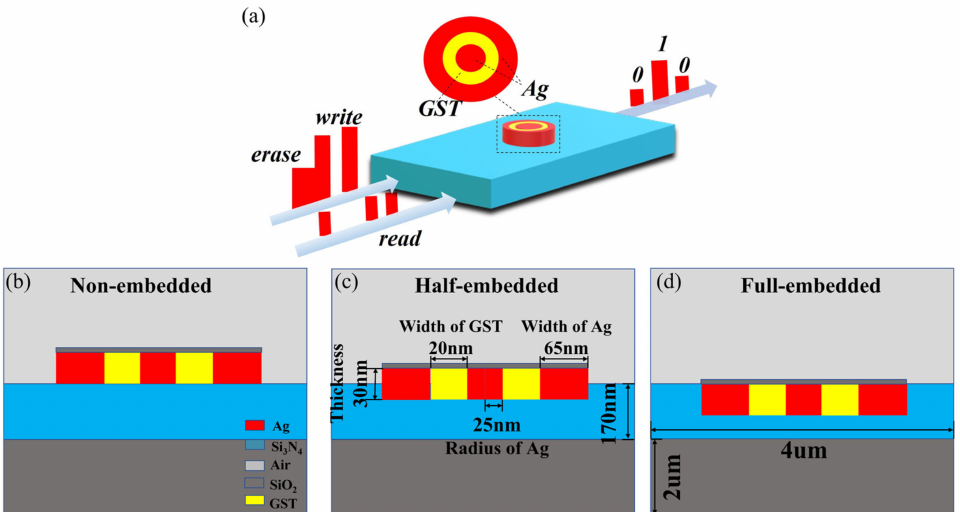
Figure 1. Schematic diagram of the devices. ( a ) Plasmonically-enhanced all-optical integrated phase- change device. PCM is surrounded by a plasmonic nanostructure consisting of two silver rings and is placed on a Si 3 N 4 waveguide. The plasmonic enhancement of the electromagnetic field produced by the nanoantenna of silver rings facilitates the phase transition of PCM with fast switching speed and low power. The large contrast in the refractive index of GST between amorphous and crystalline states can be utilized to modulate the device transmission. The high and low transmission of the device represents the stored data “1” and “0”. Reading and writing/erasing operations are carried out by transmitting laser pulses through integrated waveguides. Cross-sectional schematic diagram of the photonic memory: the structure ( b ) completely above, ( c ) half-embedded, and ( d ) full-embedded in the